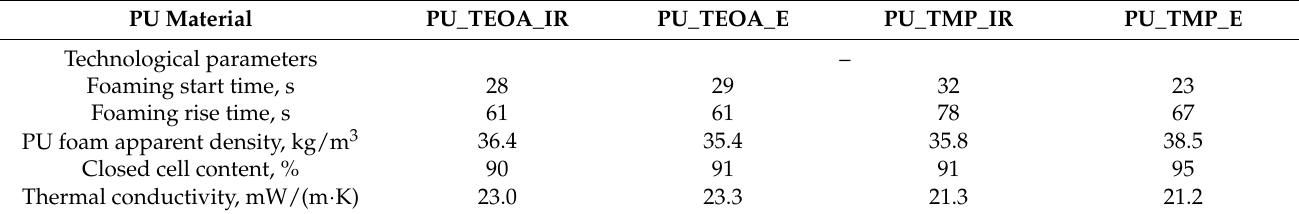
Table 4. The common characteristic of developed rigid PU foams based on TOFA-type bio-polyols. PU